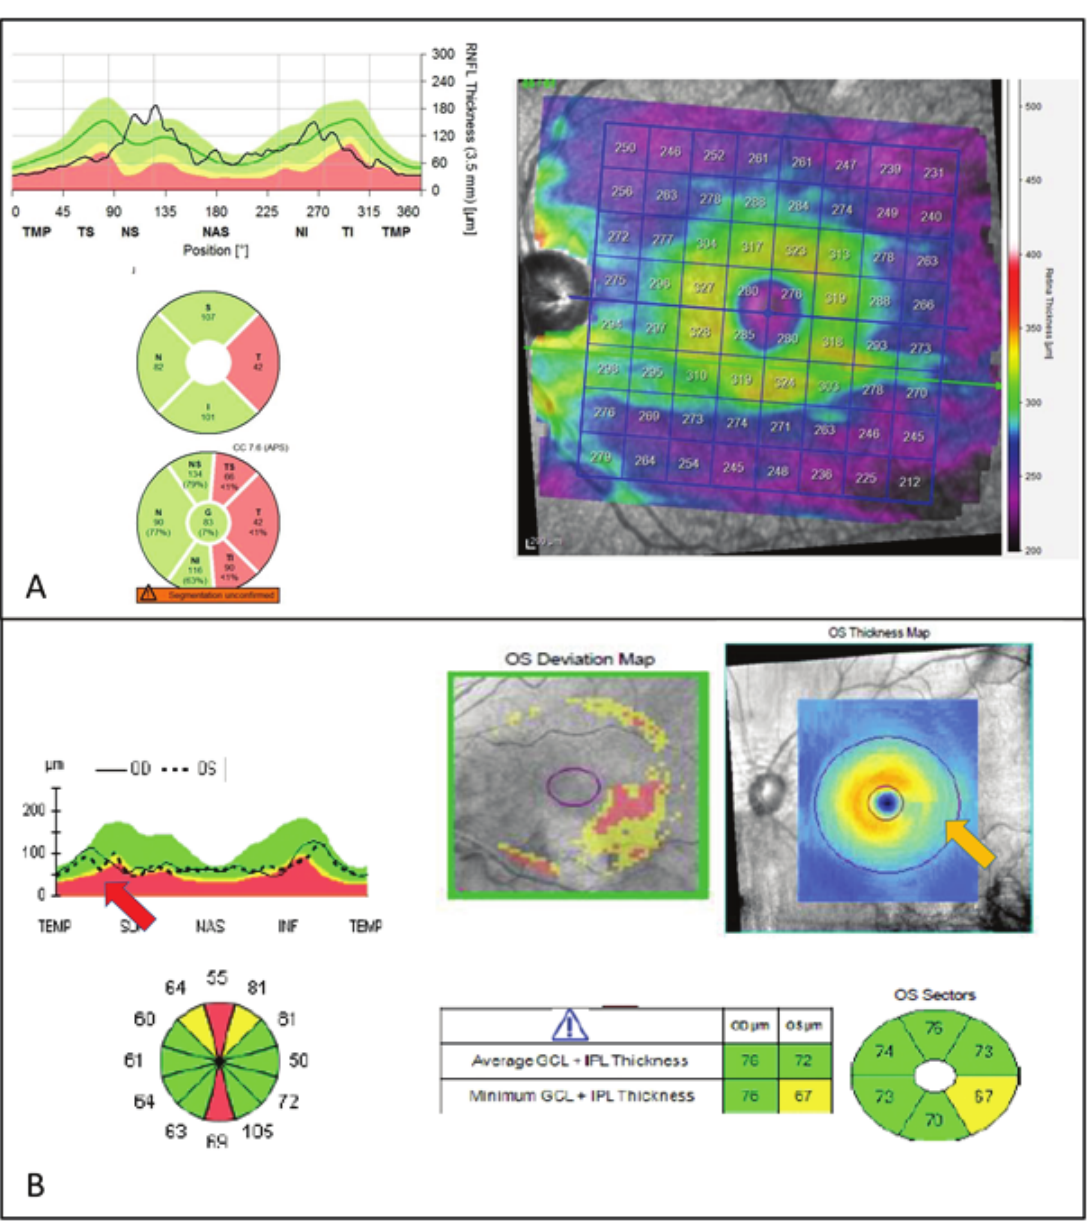
Figure 2. (A) Myopic eye without glaucoma. Myopic eye shows “red disease” with abnormal sectors in the inferotemporal, supratemporal, and temporal sectors which is probably due to temporal displacement of RNFL peaks and not glaucomatous damage. This is confirmed by normal macula thickness in the Posterior Pole Map. (B) Myopic eye with glaucoma. The OCT image shows thinning of the inferior and superior quadrants. This “red disease” might be due to the temporal displacement of RNFL peak. However, GCIPL report shows typical raphe sign (yellow arrow) and inferotemporal macula inner layer thinning suggesting glaucomatous damage. Detailed examination of RNFL profile also depicts a decrease in thickness of superior peak (red